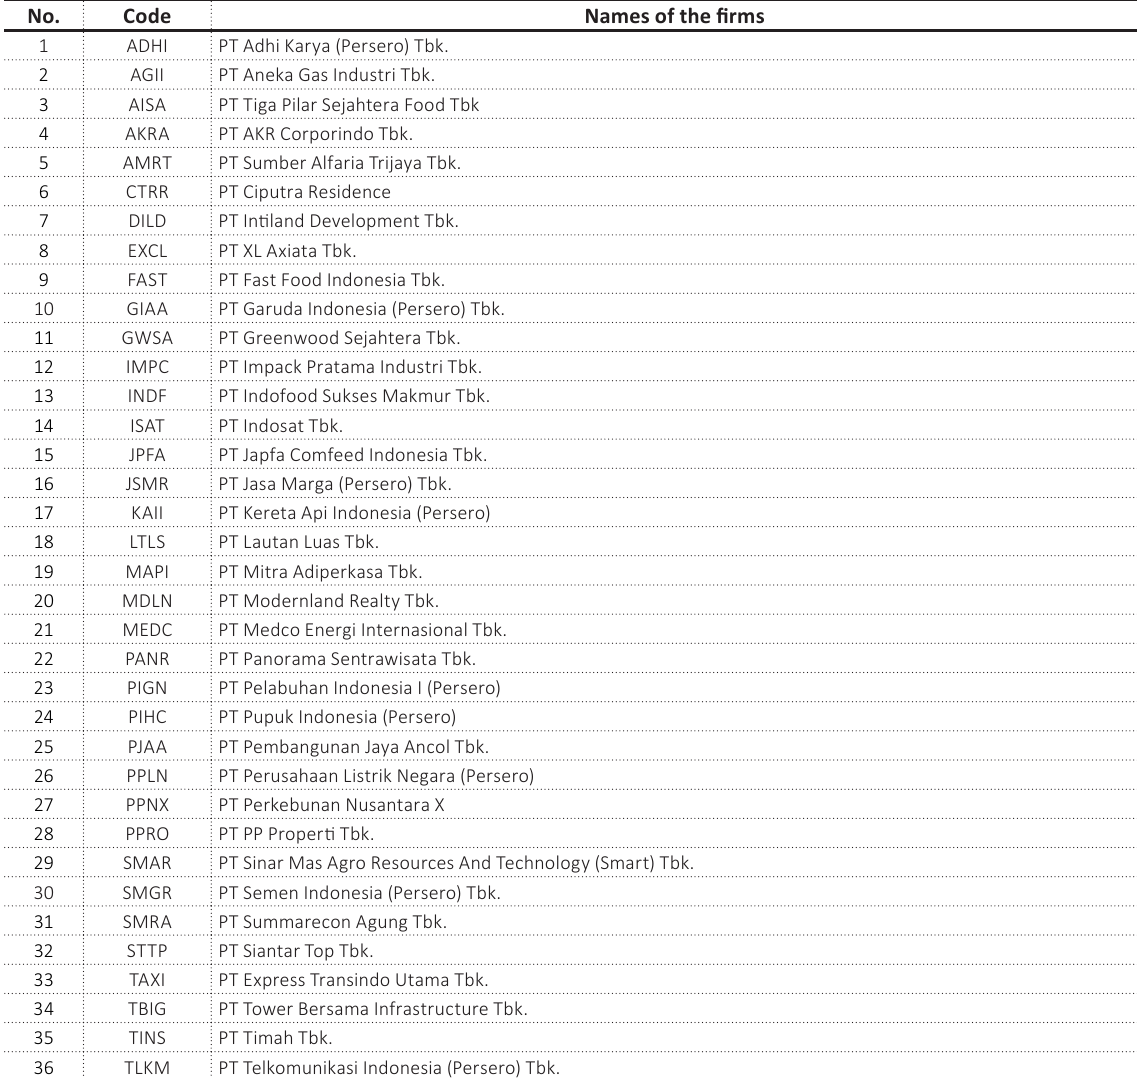
Table A1. Names of the companies as the